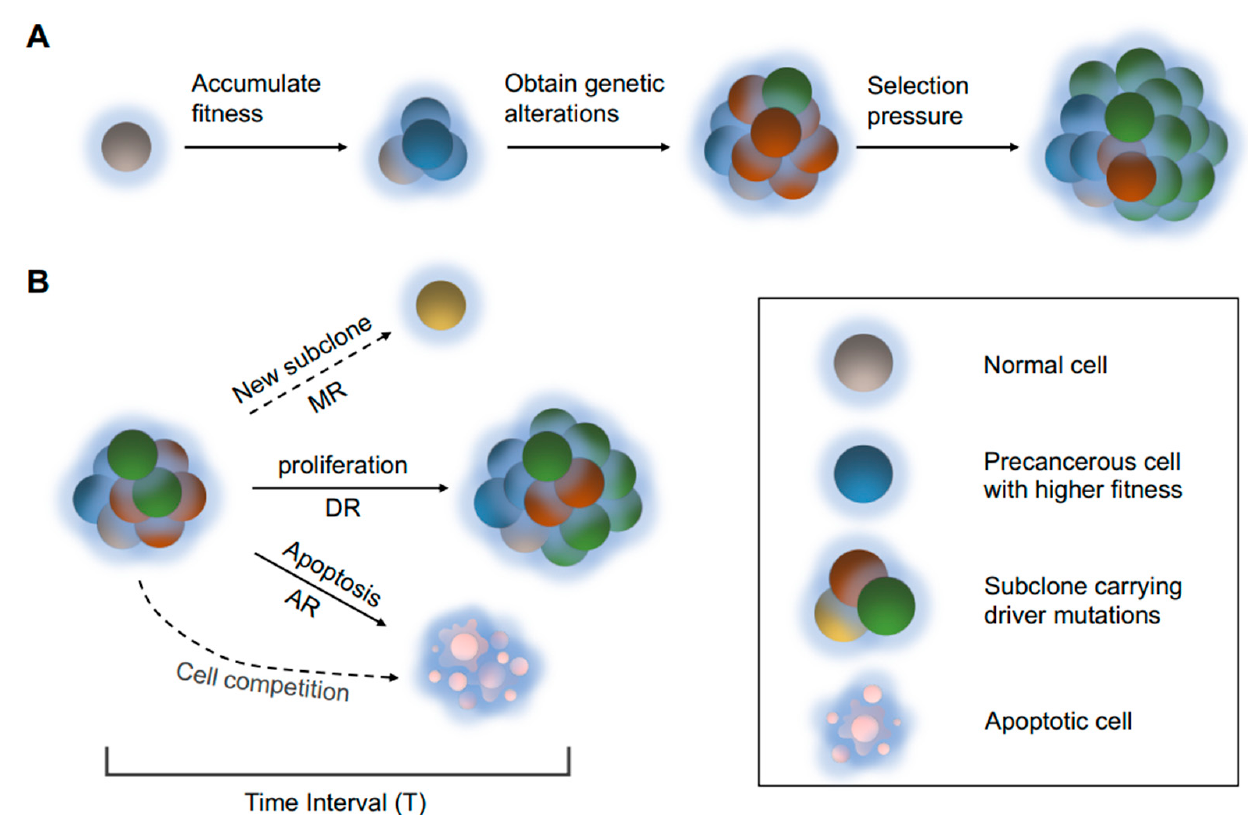
Figure 1. ( A ) An illustration of the clonal evolution process. Cells may accumulate mutations with different functional consequences over generations. During the process, a “driver mutation” may occur and provide a substantial increase in cell fitness, leading to further expansion of the corresponding clone. Different subclones in tumor may yield distinct responses to external pressure. ( B ) A schematic of cell population alteration process in the model. In the time interval T, all subclones may proliferate or decease individually according to their division rates ( DR s) and apoptosis rates ( AR s). The chances for the emergence of a new subpopulation correlates to the mutation rate ( MR ). When the total cell population is high, cell competitions will cause the elimination of less competent cells.